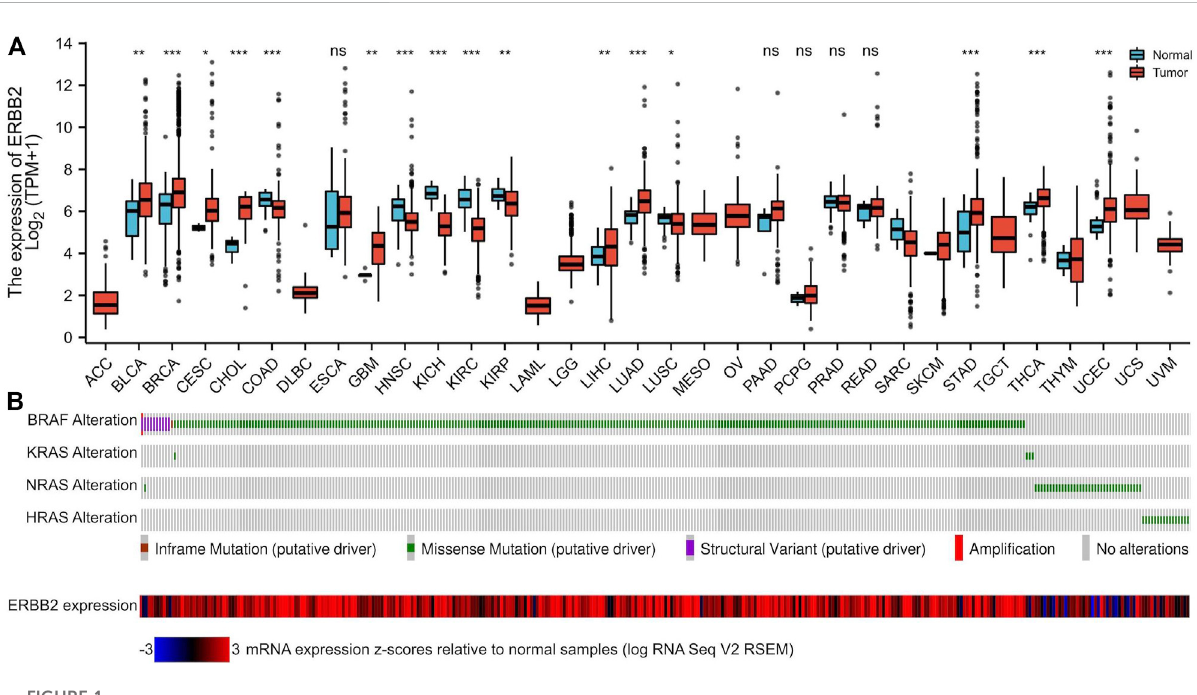
FIGURE 1 The mRNA expression of ERBB2 in pan-cancers and tumor-adjacent normal samples. (A) Compared with paired normal tissues, mRNA expression of ERBB2 was upregulated in 16 cancer datasets: BLCA ( p = 0.007), BRCA ( p < 0.001), CESC ( p = 0.034), CHOL ( p < 0.001), GBM ( p = 0.002),LIHC( p =0.008),LUAD( p < 0.001),STAD( p < 0.001),andTHCA( p < 0.001)andUCEC( p < 0.001). (B) TheOncoPrintplotdisplaysanoverview of gene alterations of the BRAF , KRAS , NRAS , and HRAS , and the expressionof ERBB2 in papillary thyroid cancer samples from TCGA. * p < 0.05, ** p < 0.01, *** p <